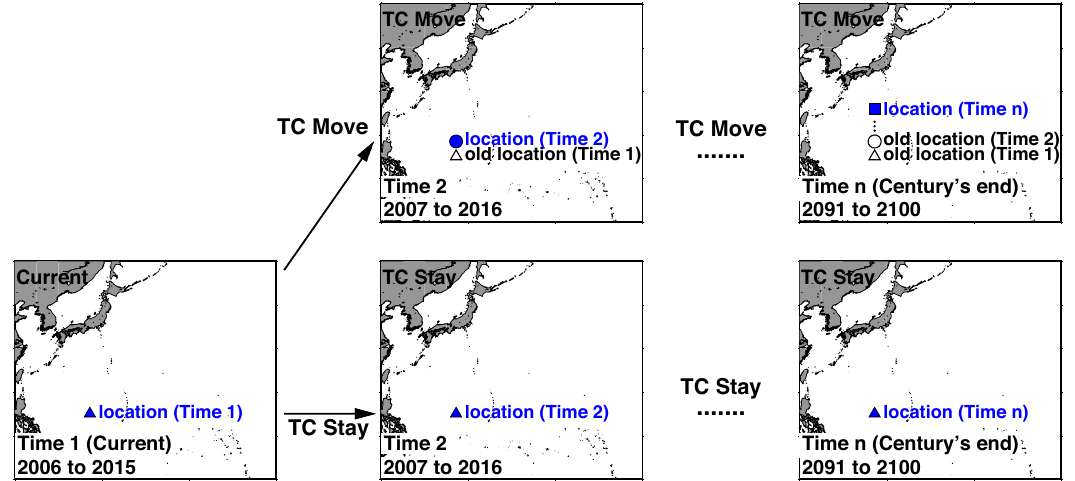
Fig. 2 Schematic diagram comparing the 2 PI projection scenarios. TC_Stay (i.e., no poleward migration) vs. TC_Move (poleward migration included) projections. For simplicity, only one TC track location (in blue) is shown to represent the TC locations at any given